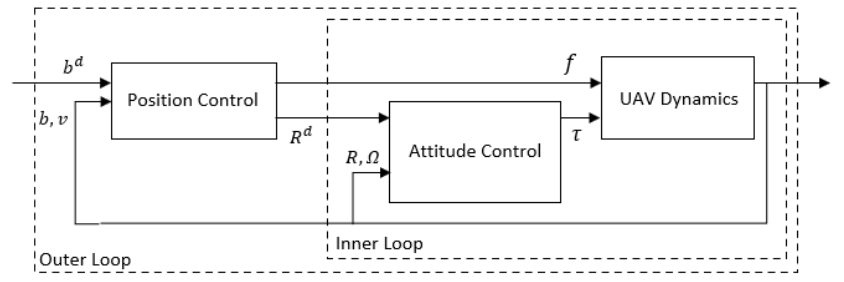
Figure 2. Block diagram of a quadrotor UAV control